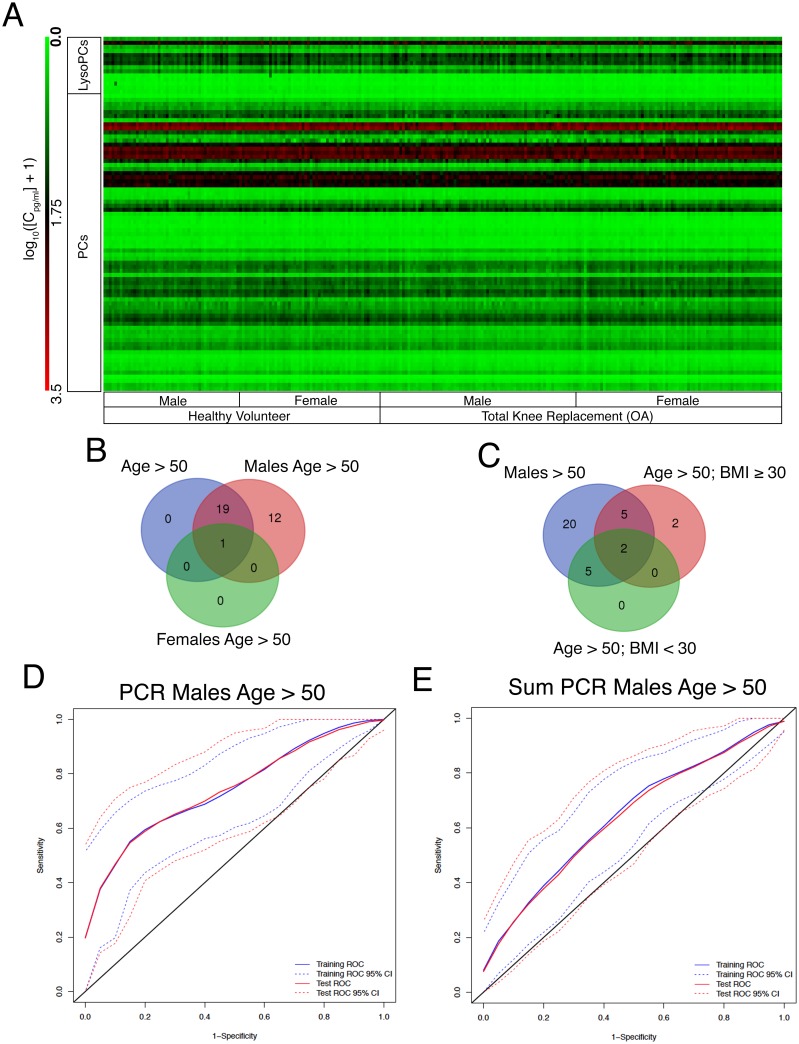
A discrete lysoPC and PC signature of metabolites from males over the age of 50 was dominant in individuals over the age of 50 years and was indicative of males with OA versus HV.(A) Heat-map of the stratified cohort of individuals overs the age of 50 years separated by sex and total knee replacement due to osteoarthritis (OA) vs healthy adult volunteers (HV). (B & C) Venn diagrams generated by metabolite signatures (Table 2) from males, females and all individuals over the age of 50 years (B) or males, individuals with body mass index (BMI) ≥ 30 or BMI < 30 kg/m2 (C). (D & E) AUC curves generated by principal component with logistic regression (PCR) modeling using the metabolite signature (D) or aggregate sum of lysophosphatidylcholine (lysoPC), diacyl-phosphatidylcholine (PCaa) and acyl-alkylphosphatidylcholine (PCae) analogues (E) from the male age > 50 years stratified population. Blue lines represent training set area under the curve (AUC). Red lines represent test set AUC. Dotted lines are 95% confidence intervals.